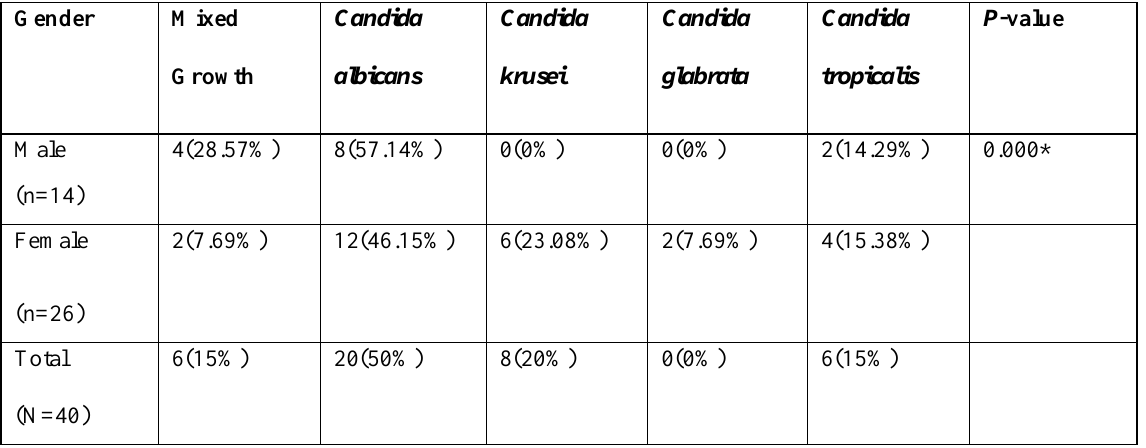
Table 5. Candida isolates in relation to age of participants